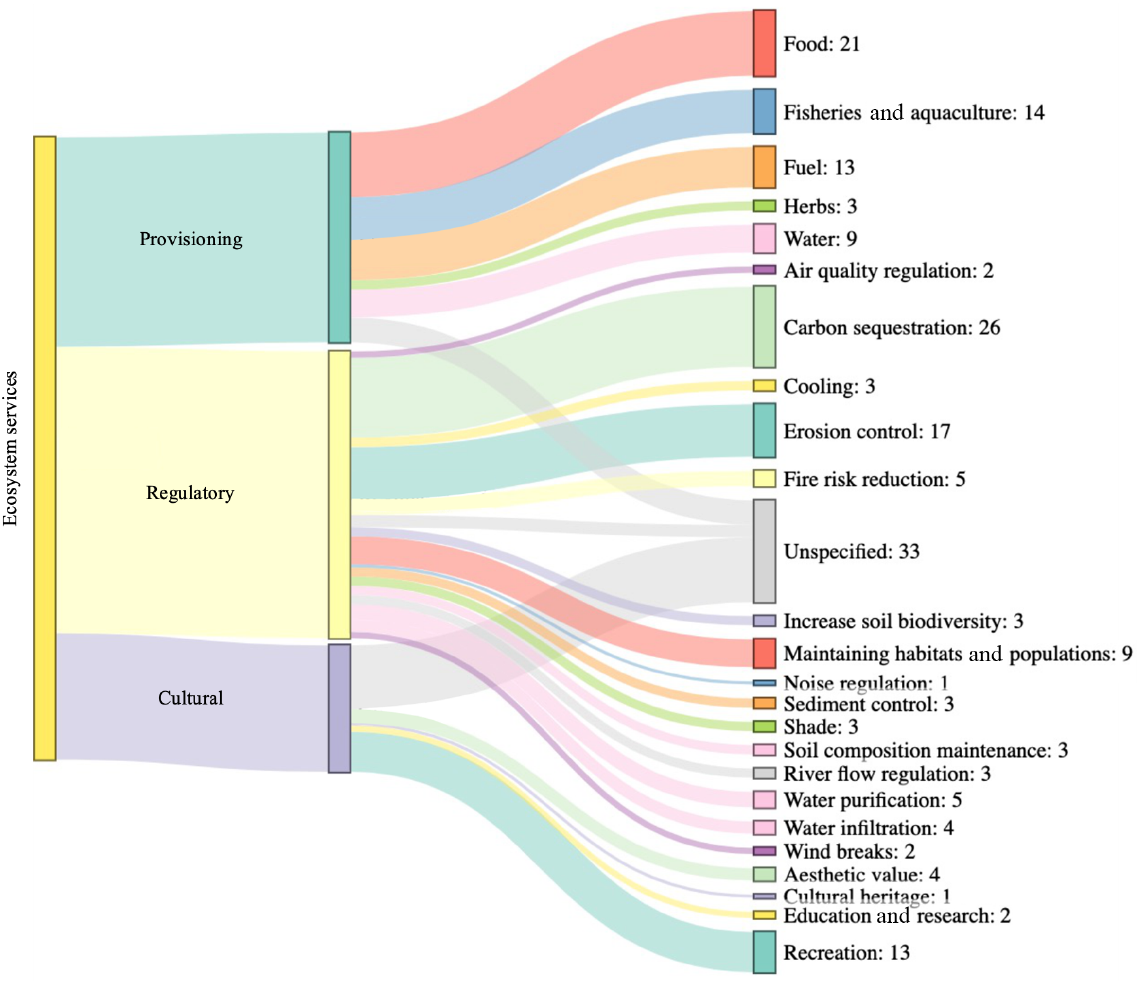
Figure 7. Ecosystem services provided by NBS initiatives beyond the hazard mitigation studied.